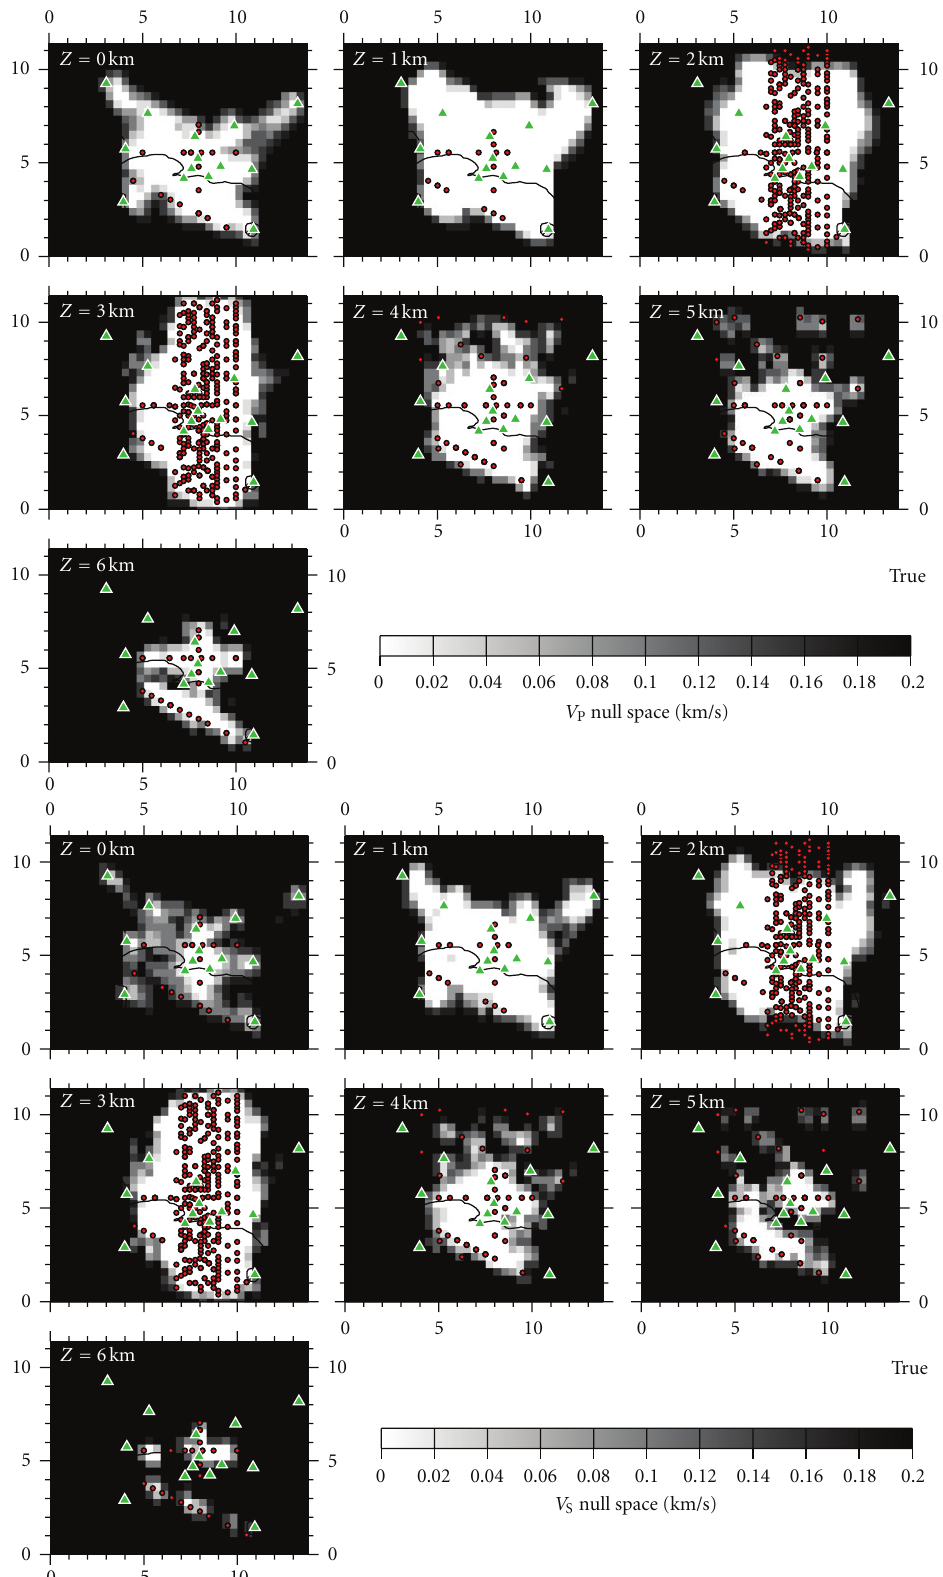
Figure 12: Same as for Figure 11, but for horizontal